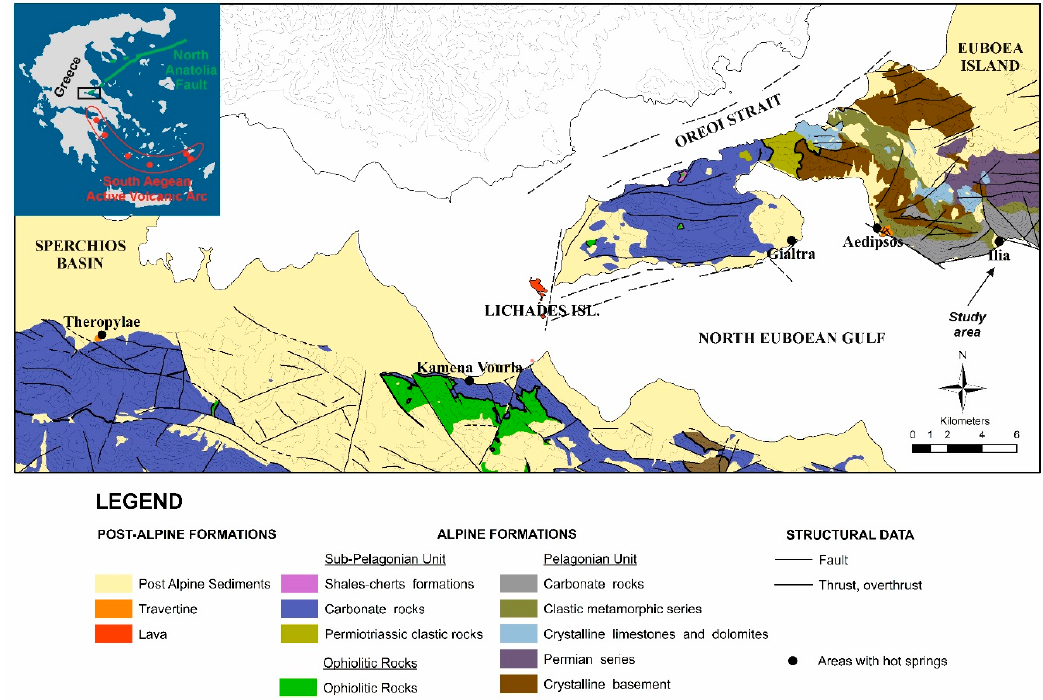
Figure 1. Simplified geological map of Northern Euboea island and neighboring area of Sperchios (mainland; modified from [69]).